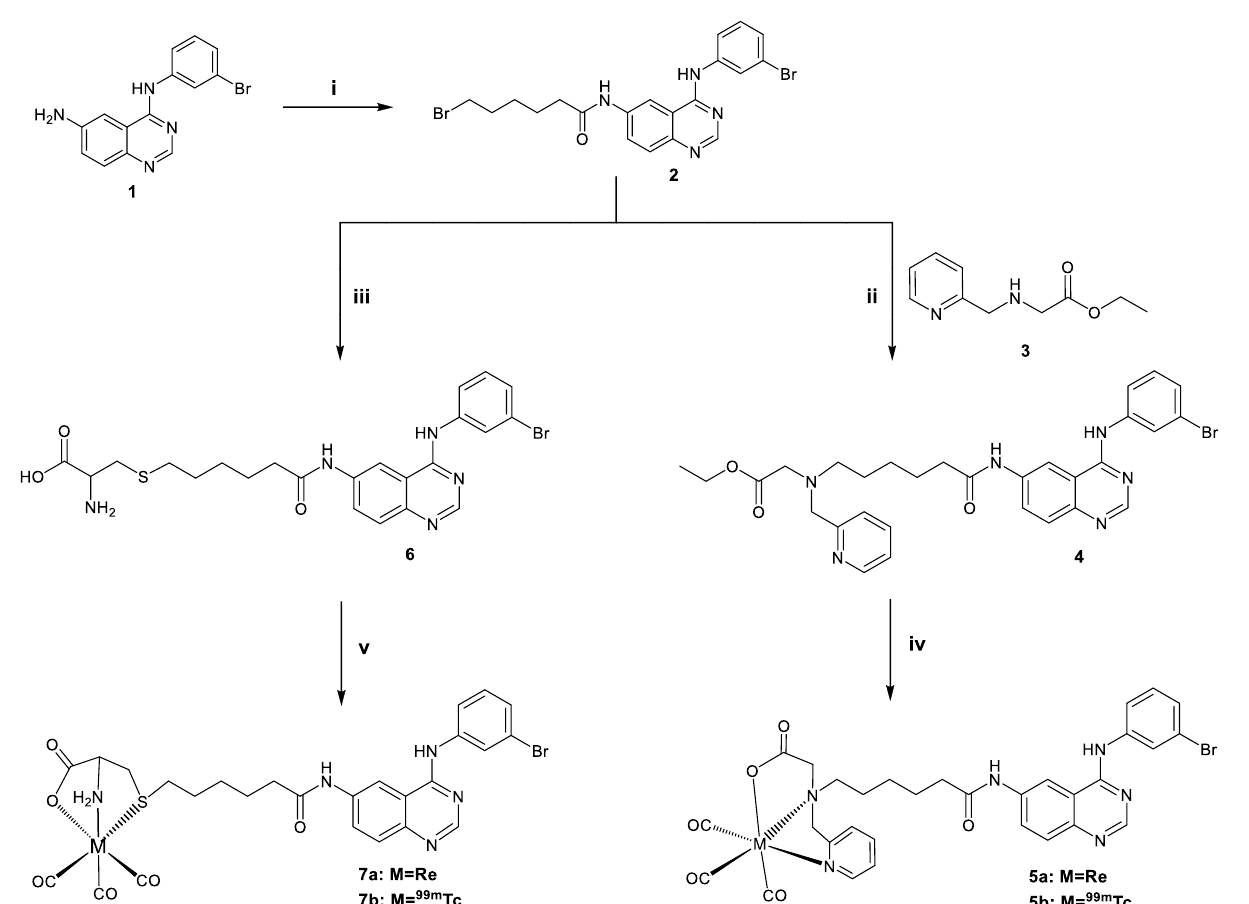
Figure 1. Synthesis of ligands 4 , 6 and complexes 5a , 5b , 7a , 7b . i : 6-bromo hexanoyl chloride, anhydrous THF, 0 °C 30 min, rt for 3 h, ii : NaI, DIPEA, THF, CH 3 CN, reflux, 18 h, iii : L -cysteine, NaOH, EtOH, rt, 18 h, iv , and v : fac -[NEt 4 ] 2 [ReBr 3 (CO) 3 ] (Method A), [ReBr(CO) 5 ] (Method B), fac - [ 99m Tc][Tc(OH 2 ) 3 (CO) 3 ] +